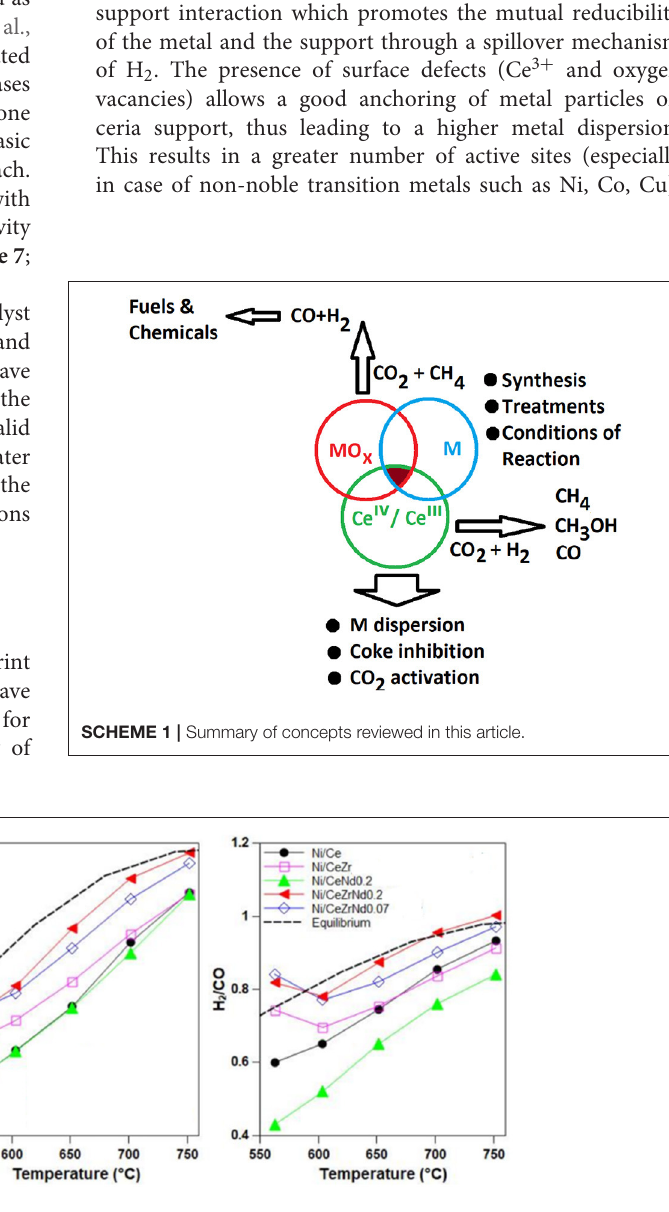
Frontiers in Chemistry |